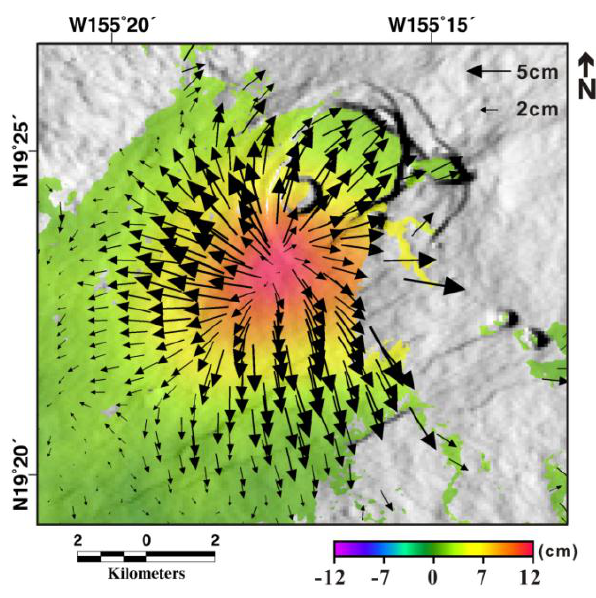
Figure 4. The horizontal displacement vector field generated from the east and north components of surface deformation. The arrows indicate the magnitude and directions of the horizontal displacements, and the colored map represents the vertical